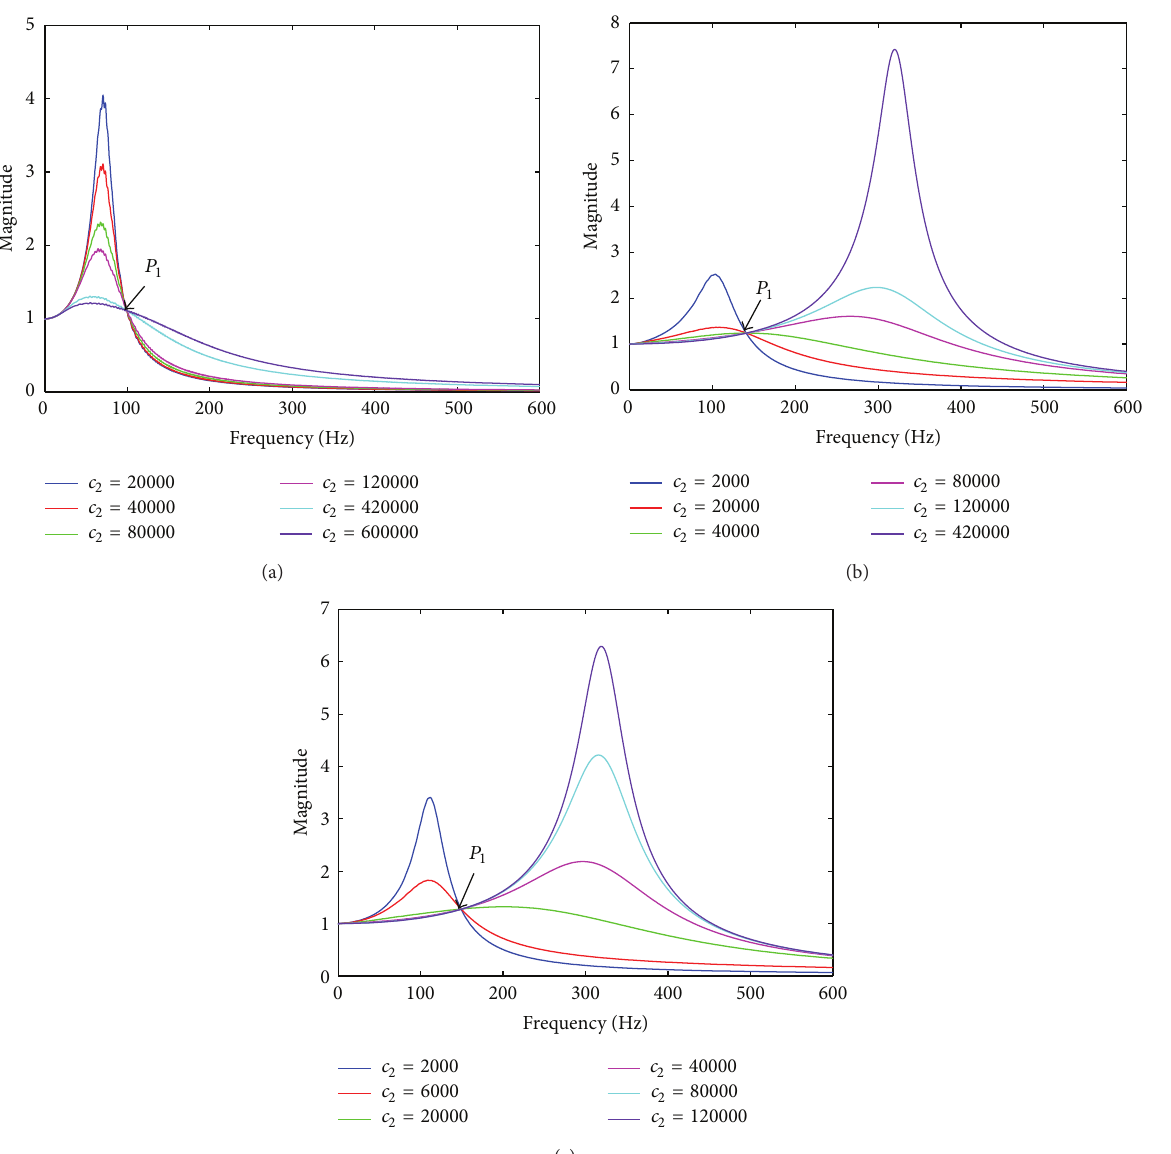
pass through one common point 𝑃 1 or 𝑃 2 , at which there is the lowest resonant peak and it can be the critical point between the first resonant region and the second resonant region. With the increase of damping coefficient 𝑐 1 , the fundamental frequency of system transfers from the first resonant region to the second resonant region, while the resonant peak firstly reduces to 𝑃 1 or 𝑃 2 point and then increases with the raise of damping coefficient 𝑐 1 . Furthermore, in the first resonant region, the smaller the damping coefficient 𝑐 1 is, the larger the high frequency roll-off rate is, but there is an opposite situation in the second resonant region. When the frequency is larger than 150 Hz, the high frequency roll-off rates under different damping coefficients 𝑐 1 become consistent with each other. Figure 16 shows the frequency shift rates of GNM under different excitation